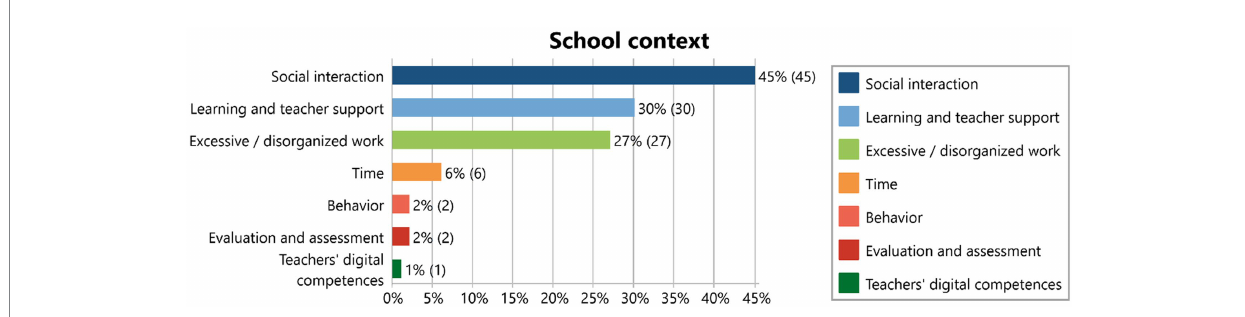
FIGURE 6 Frequency of documents referring to the subcategory School context, within the category Children’s